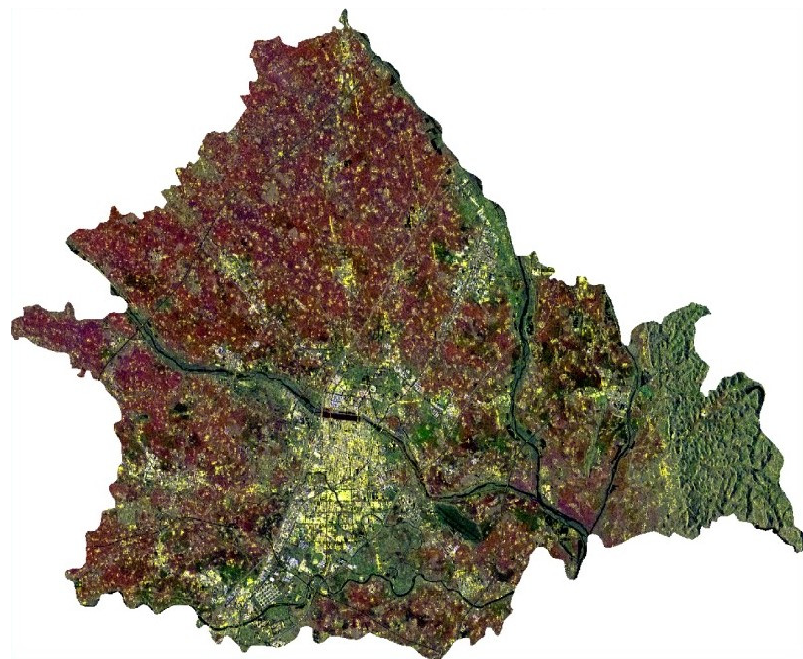
Figure 18. Multi-time-phase RGB composite image. Time series + coherence coefficient refers to time-series SAR combined with the polarization coherence coefficients on 12 June and 11 August, and the results are shown in R (12/06VV), G (11/08VV), and B (12/06VV coherence coefficient) in three channels (Figure 19). In Figure 19, rice is colored dark red, water is colored black, artificial buildings are colored blue and white, and vegetation is colored light green. The color can be used to easily distinguish rice from other ground